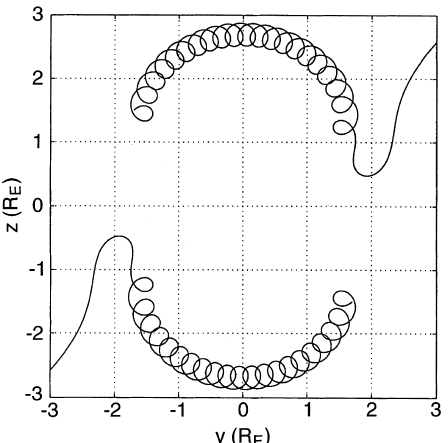
Fig. 6. Planar meridional trajectories of a proton (100 keV) in a tesseral octupole magnetic field ( m (cid:136) 1, n (cid:136) 3; g 1